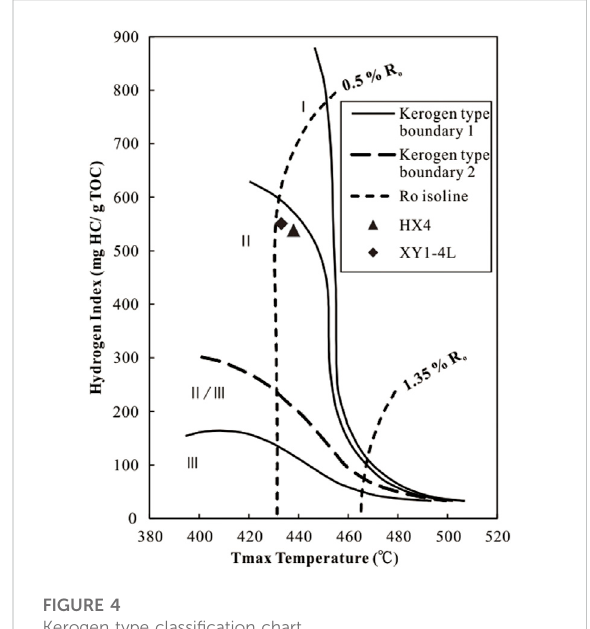
FIGURE 4 Kerogen type classi fi cation